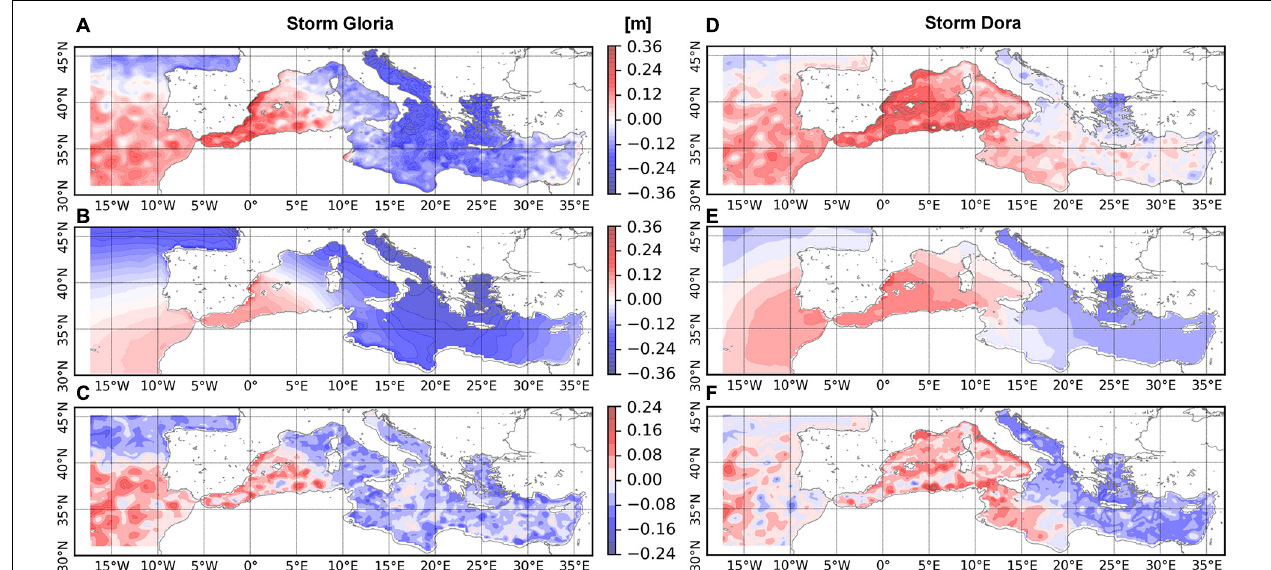
FIGURE 13 | Left panels: Storm Gloria: hourly non-tidal residuals from MedFS (A) , Nivmar (B) , and differences (C) at 2020/01/20 08:00 UTC. Right panels: Storm Dora: hourly non-tidal residuals from MedFS (D) , Nivmar (E) , and differences (F) at 2019/12/04 18:00 UTC. Units in meters.